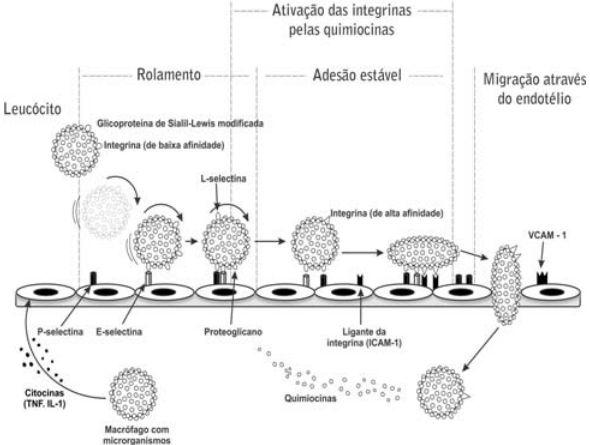
Fig. 2 - Etapas do processo de migração